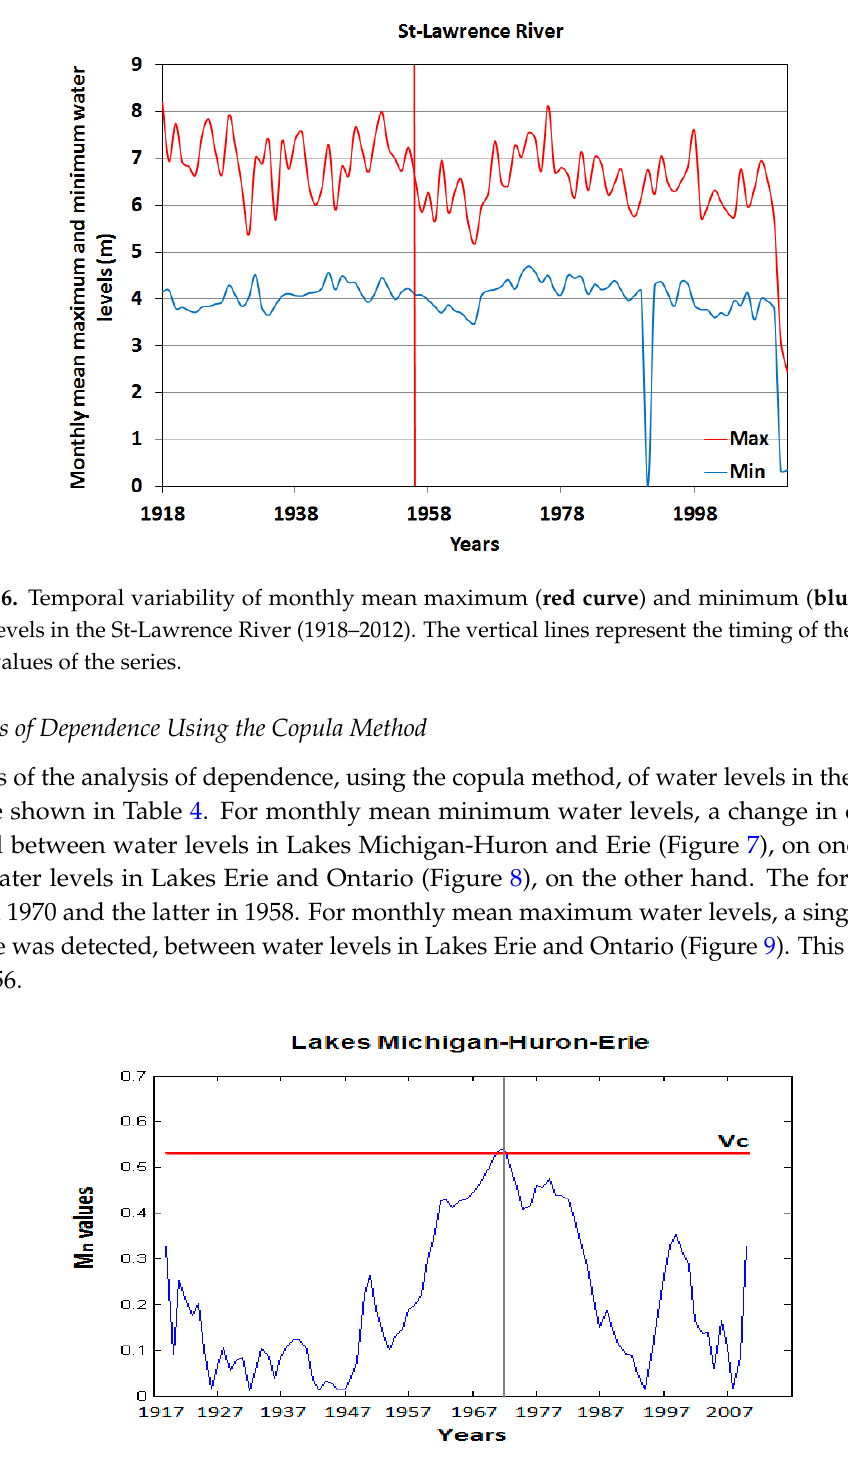
Figure 8. Analysis of dependence using the copula method. Temporal variability of M n values derived for monthly mean minimum water level series for Lakes Erie and Ontario (1918–2012). The horizontal red line shows the critical value of V c . The vertical line represents the timing of the change of dependence between the water levels. Figure 9. Analysis of dependence using the copula method. Temporal variability of M n values derived for monthly mean maximum water level series for Lakes Erie and Ontario (1918–2012). The horizontal red line shows the critical value of V c . The vertical line represents the timing of the change of dependence between the water levels.